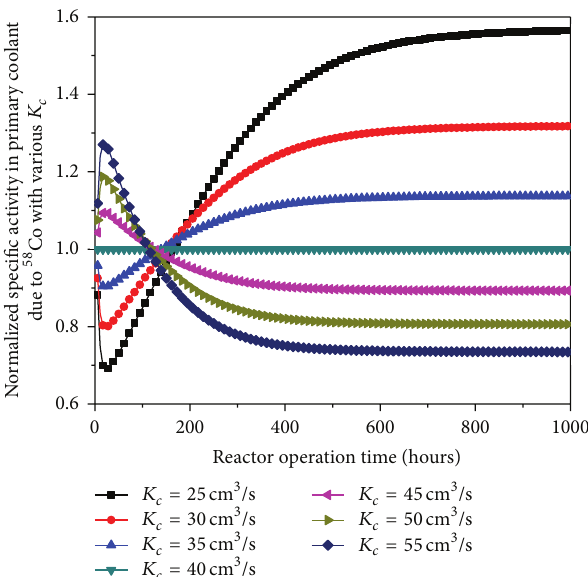
Figure 7: Specific activity of 60 Co in primary coolant of PWR with different values of 𝐾 𝑐 .